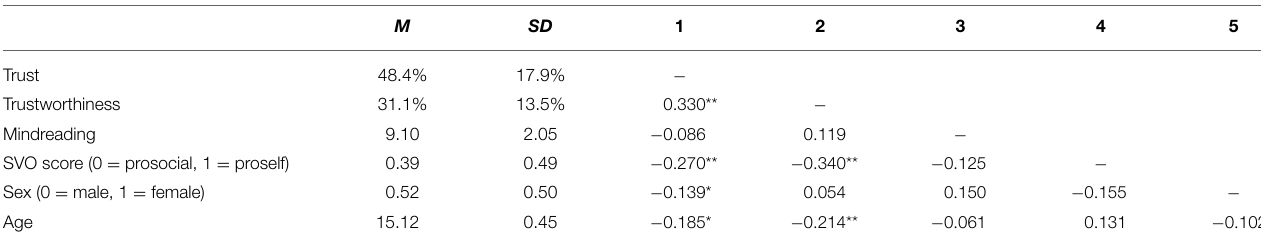
TABLE 1 | Descriptive statistics and Pearson